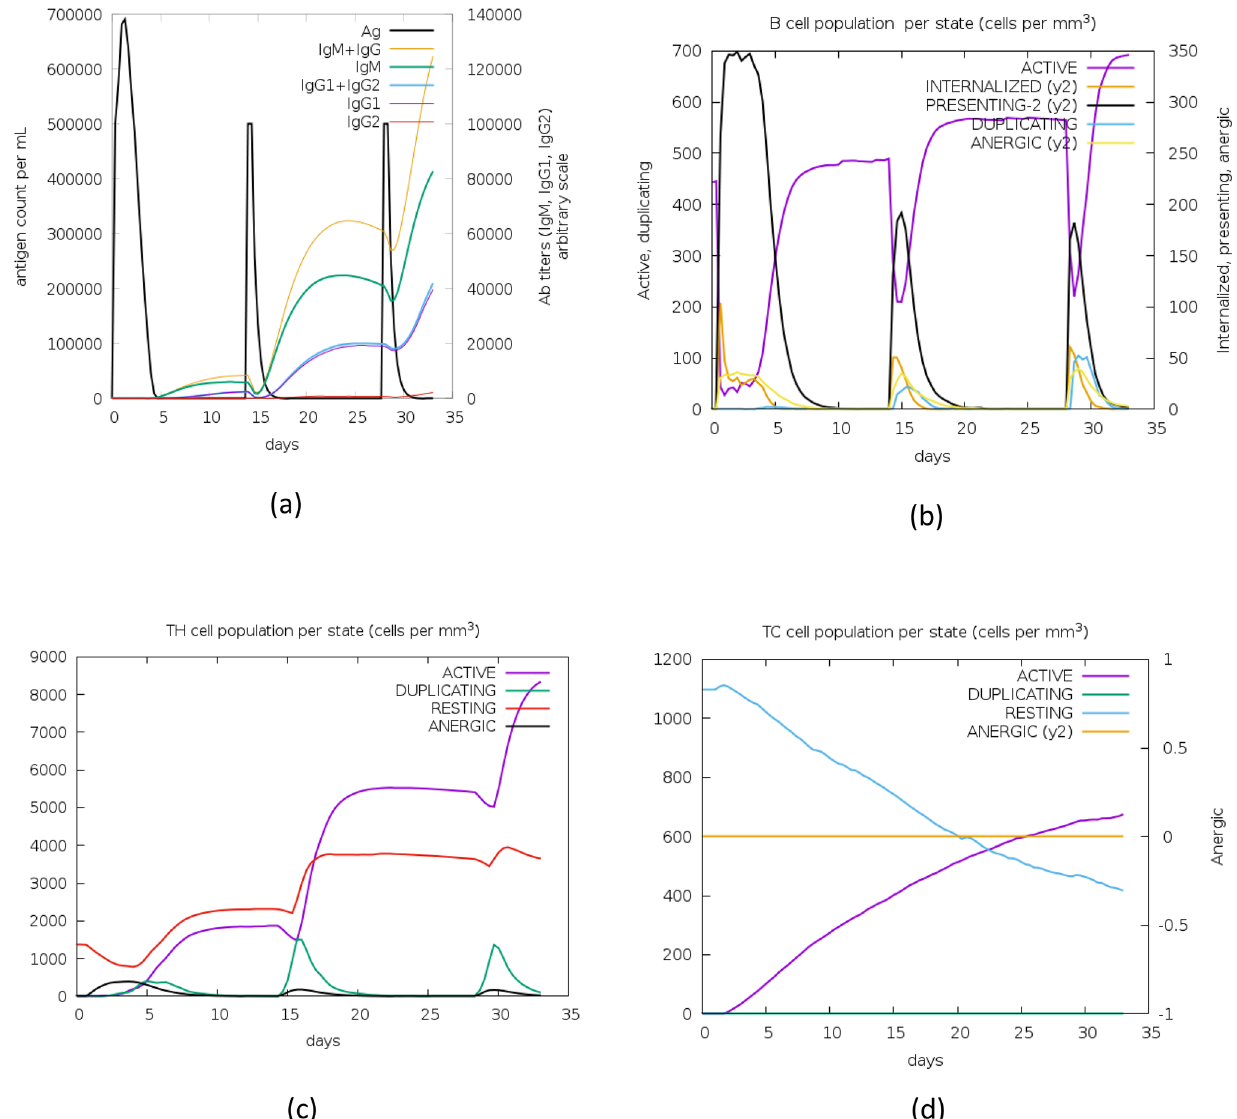
Figure 13. Molecular simulations of the chimeric protein. ( a ) Successive antigen injections leading to immunoglobulins production (Colored peaks indicate black vertical lines, along with other sub-classes of immune cells). ( b ) Post-insertion development in B-cell population per state as per observation after inserting three injections. ( c ) Development of T-helper cells ( d ) T-cytotoxic cell population per state after injections. The resting phase denotes those cells that are not presented with the antigens and energy state denotes cells that are tolerant to antigens due to repeated exposure, thereby indicating a lack of immune